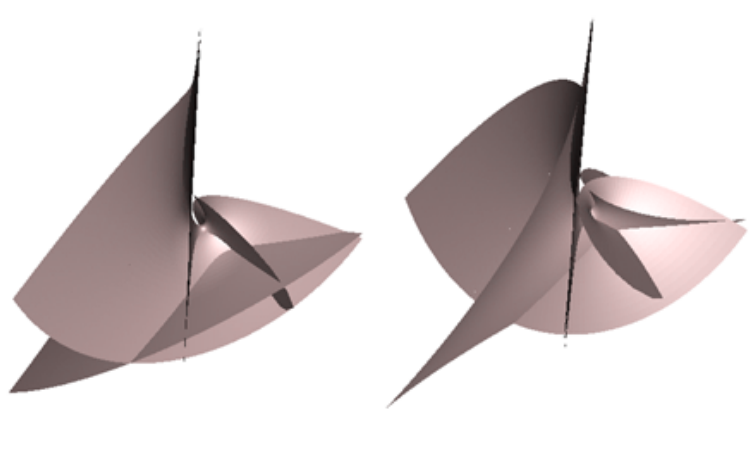
Fig. 1 – Minimal surface associated to Enneper’s surface with c = 1 , A = 0 , B = 1.